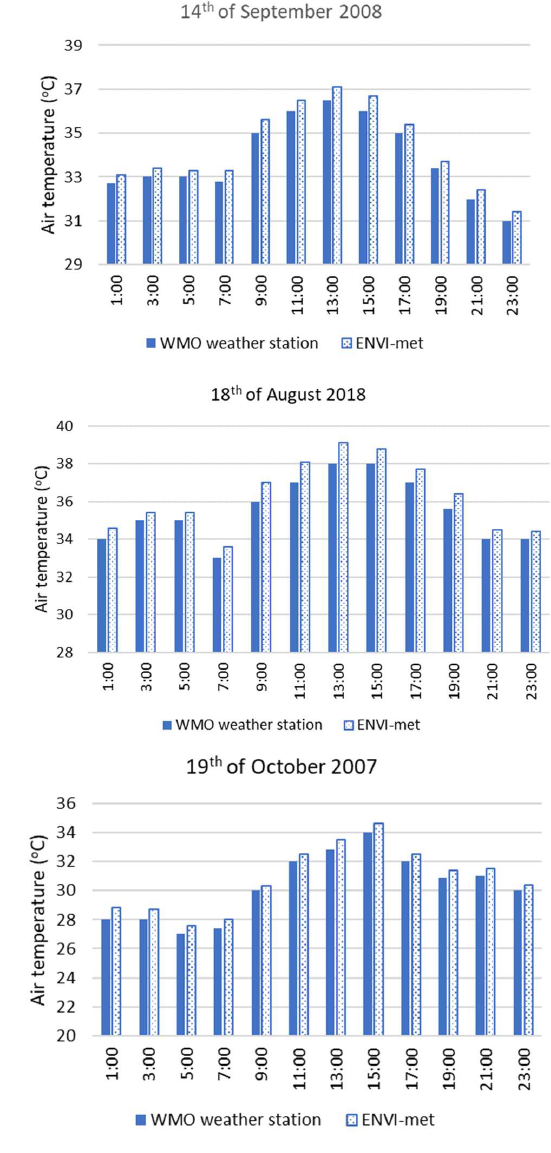
Figure 6. Variation in average air temperature reported by the WMO and the ENVI-met simulated outcomes for the representative days of summer.